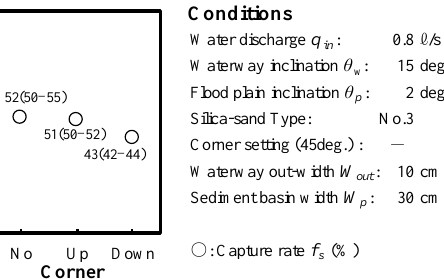
Figure 9. Effect of the presence or absence of corners in the sediment retarding basins on the capture rate f s .